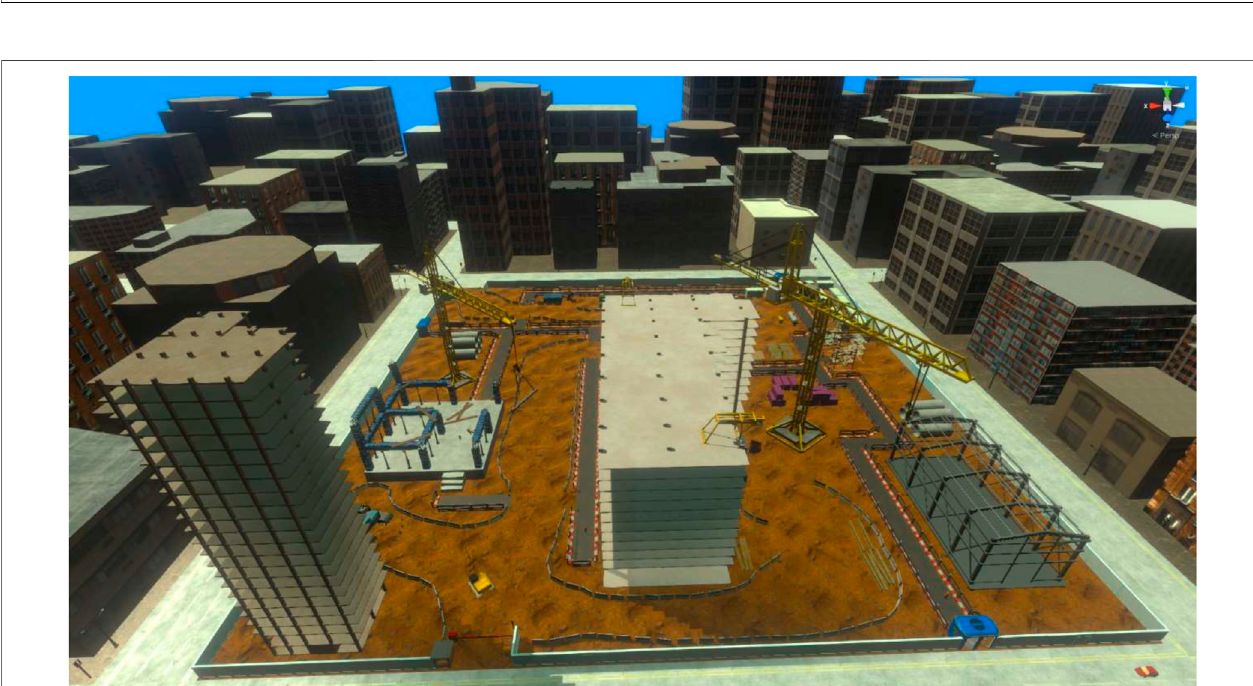
FIGURE 17 | Screenshot of the modelled construction site that is used in the game.